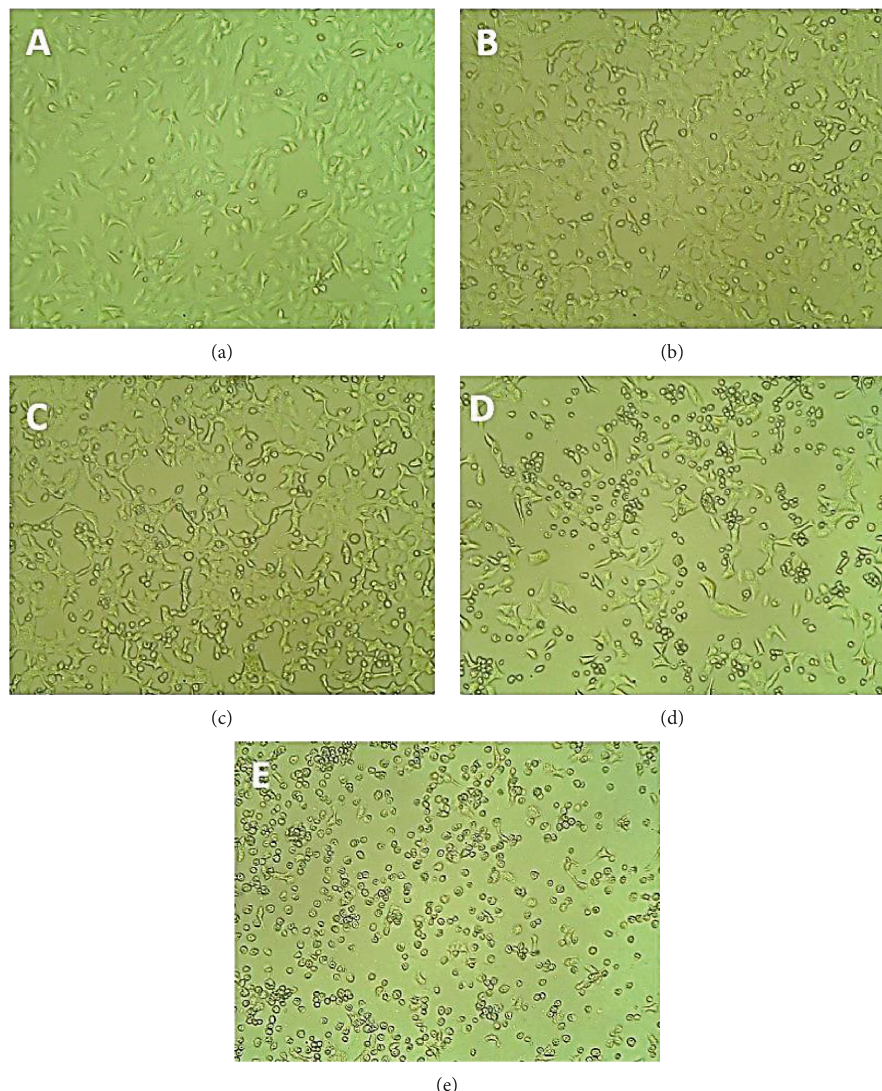
Figure 9: Phase contrast microscopic images of SP-ZnONPs-treated A549 cell lines. (a) Control, (b) 50 μ g/mL, (c) 60 μ g/mL, (d) 70 μ g/mL, and (e) standard drug